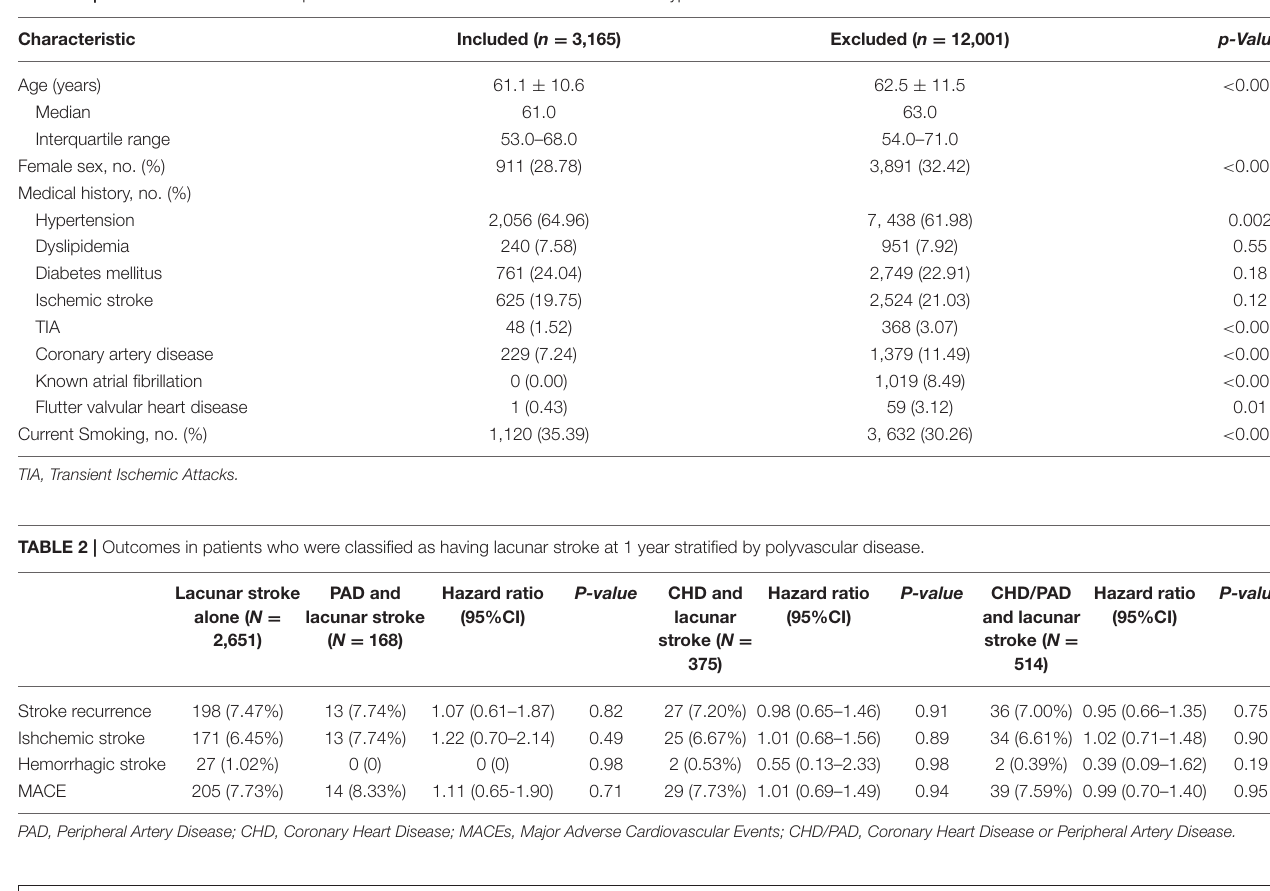
TABLE 1 | Baseline characteristics of patients with lacunar stroke vs. those with other types of stroke.